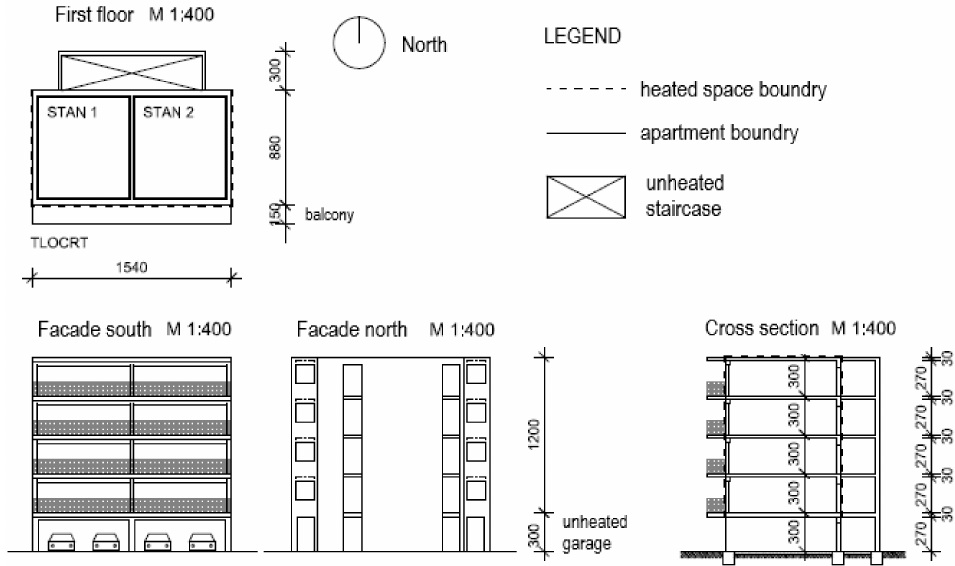
Figure 9. Design of examined building (adapted from [45]). Table 2. Main features of the reference building (data from